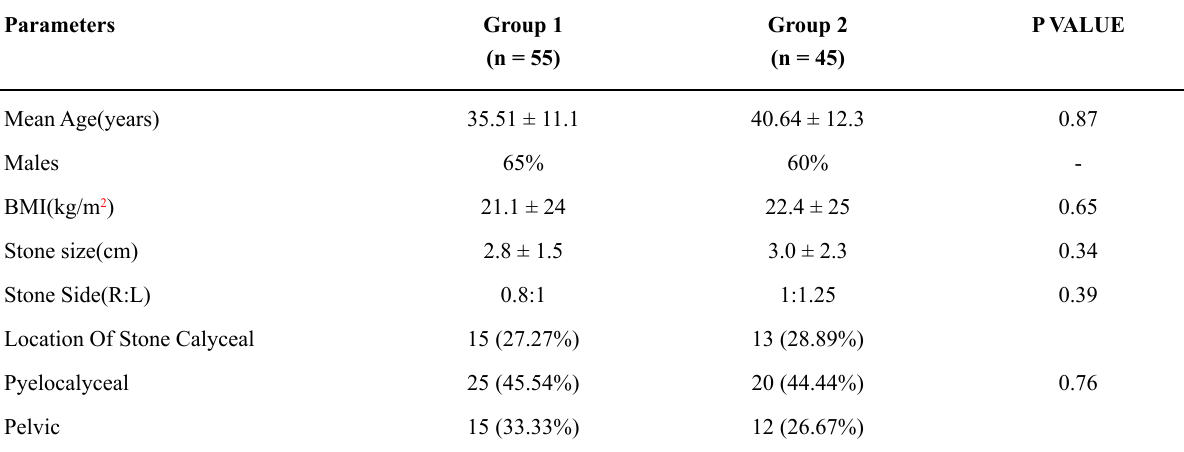
Table 1 - Demographic profile of patients in both the groups.